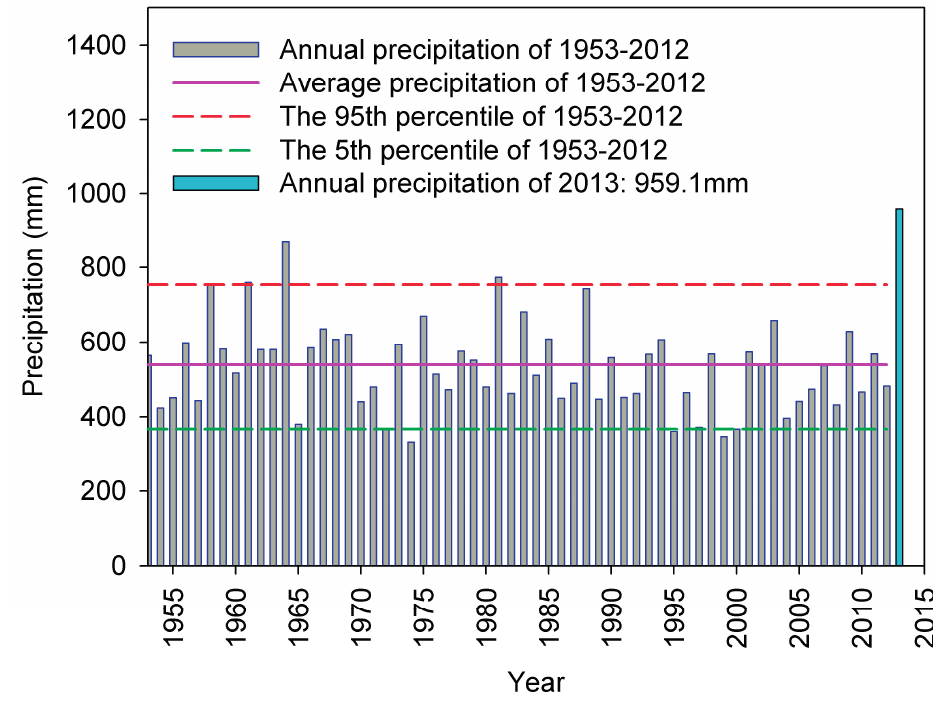
Figure 2. Variation of annual precipitation from 1953 to 2013 in